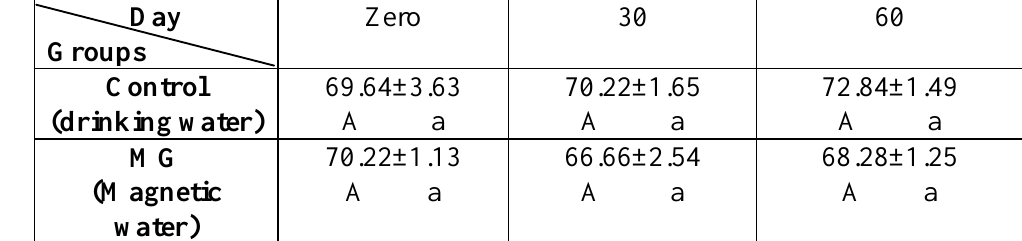
Table (4): Effect of exposure to magnetized water for 60 days on serum low density lipoprotein - cholesterol (LDL-C) concentration (mg\dl) of adult male rabbits.